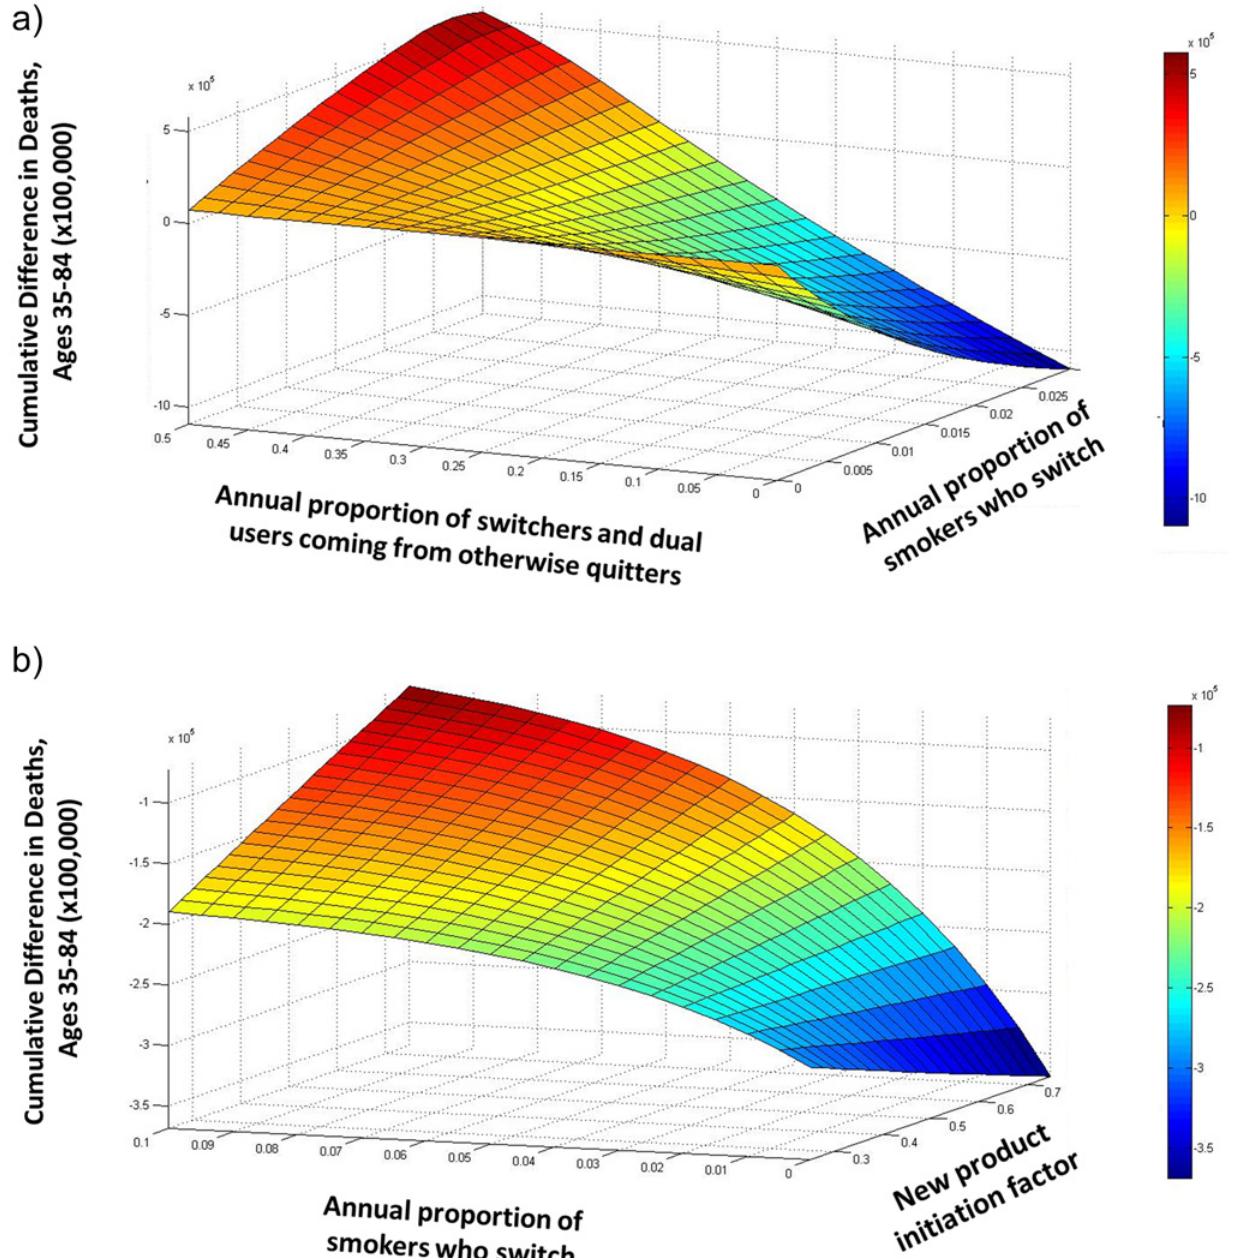
Fig 10. Bivariate parameter sweeps of (a) annual proportion of cigarette smokers switching to new product and the proportion of these switchers and dual users who would have otherwise quit smoking that year (b) new product initiation factor and annual proportion of new product users switching to cigarettes or transitioning to dual use on cumulative difference in deaths for ages 35 – 84 between the status quo and hypothetical scenario A in